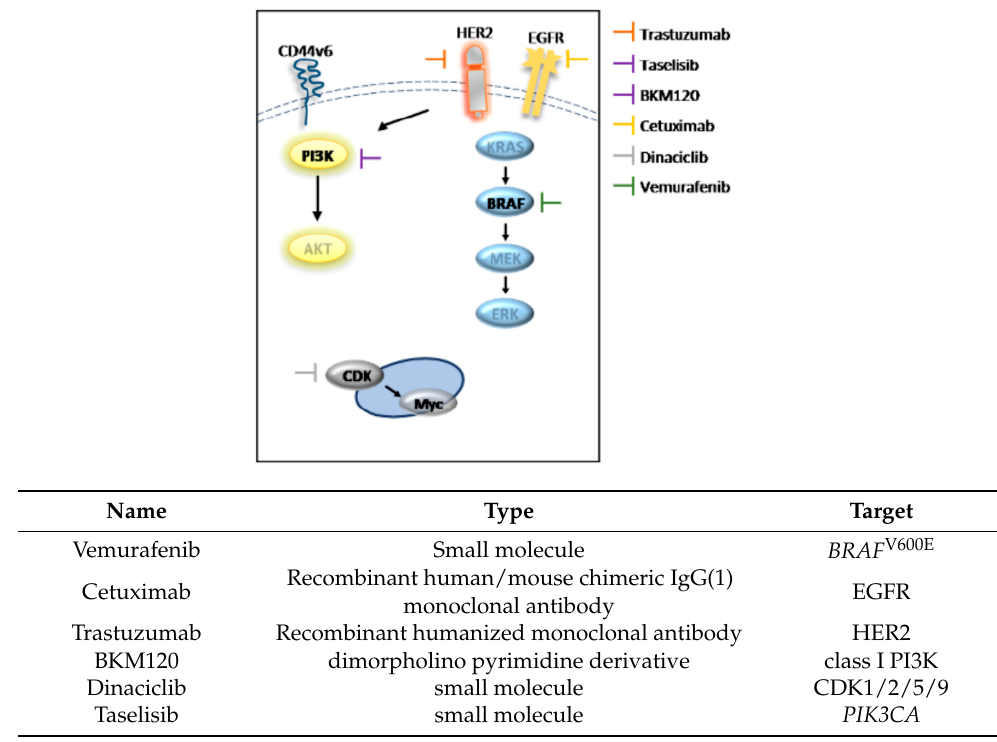
Table 2. List and diagram illustrating the site of action, type and target of each drug.